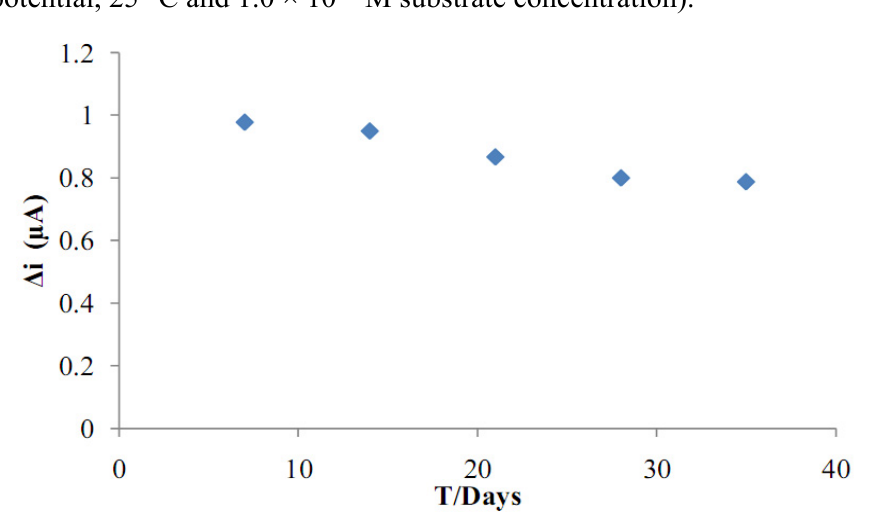
Figure 11. Storage stability of the biosensor (in pH 7.5 phosphate buffer, at 0.4 V operating potential, 25 °C and 1.0 × 10 − 5 M substrate